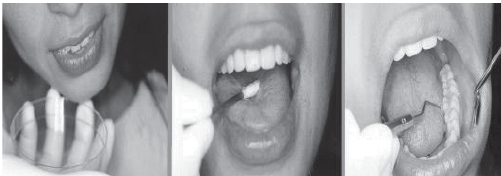
Figure 1 - Saliva; back of the tongue; sub-gingival biofilm